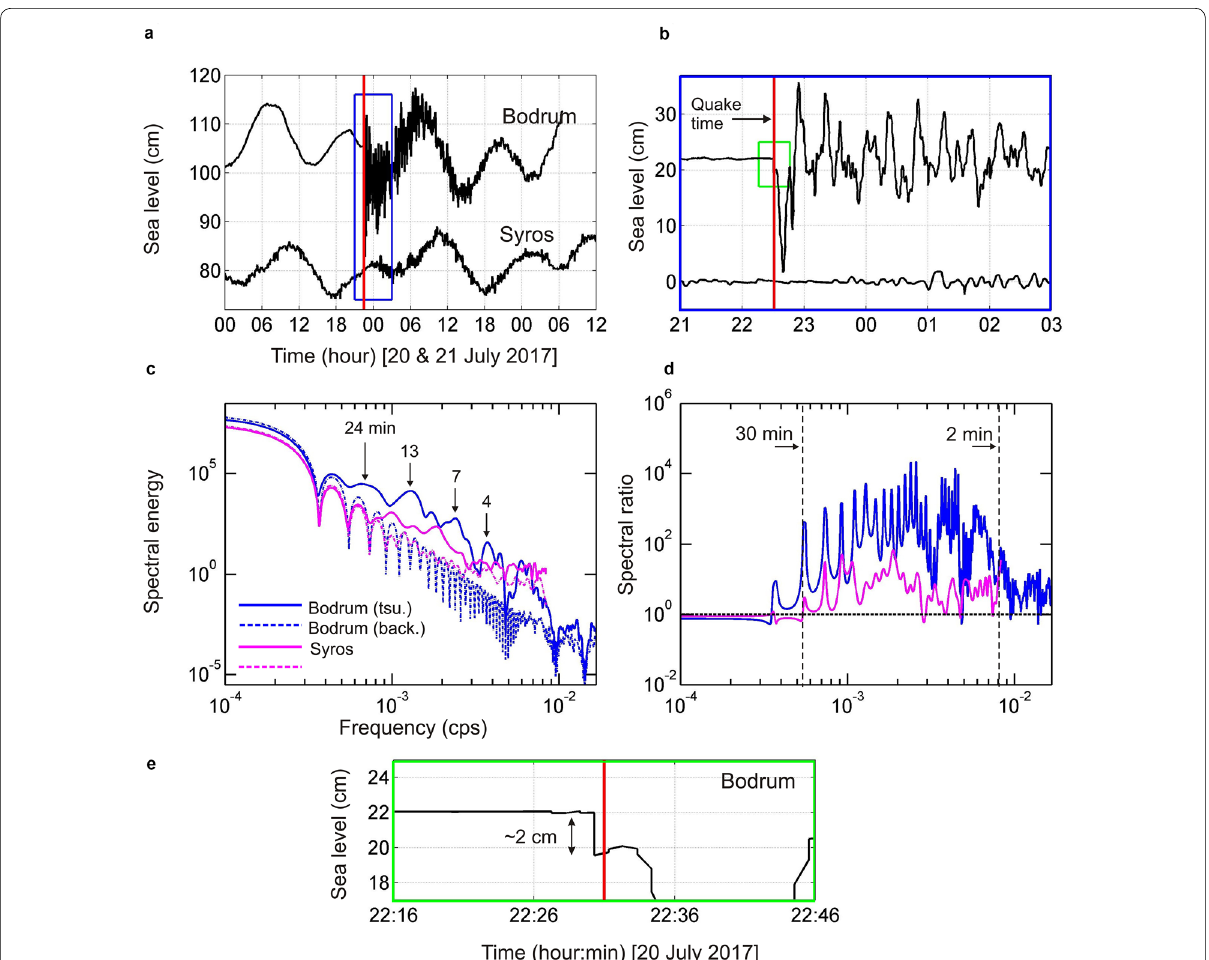
Fig. 3 Original records a and de-tided waveforms b of the 20 July 2017 Bodrum–Kos tsunami in Bodrum (Turkey) and Syros (Greece). c , d Spectra and spectral ratios at these two stations. tsu and back represent tsunami and background signals, respectively. e The enlarged view of the green rectangle shown in ( b ). In ( e ), the seafloor uplift of ~ 2 cm looks occurring 30 s before the earthquake time. Obviously, the uplift occurred simultane- ously at the earthquake origin time (red vertical line); the 30 s shift can be attributed to the temporal resolution of the